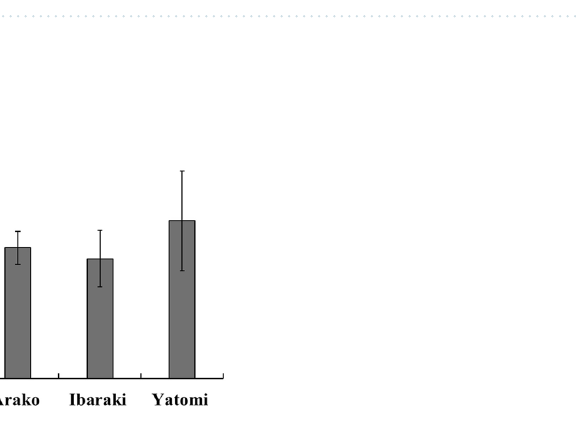
Figure 1. ( a ) ARA of the humin and no-humin consortia using testing conditions with (+) and without humin (−); ( b ) changes in the relative total nitrogen content in the cultures under four conditions during 14 days of incubation: humin consortium, no-humin consortium, humin only and control (medium only, as 100%). The humin used here was Kamajima humin.